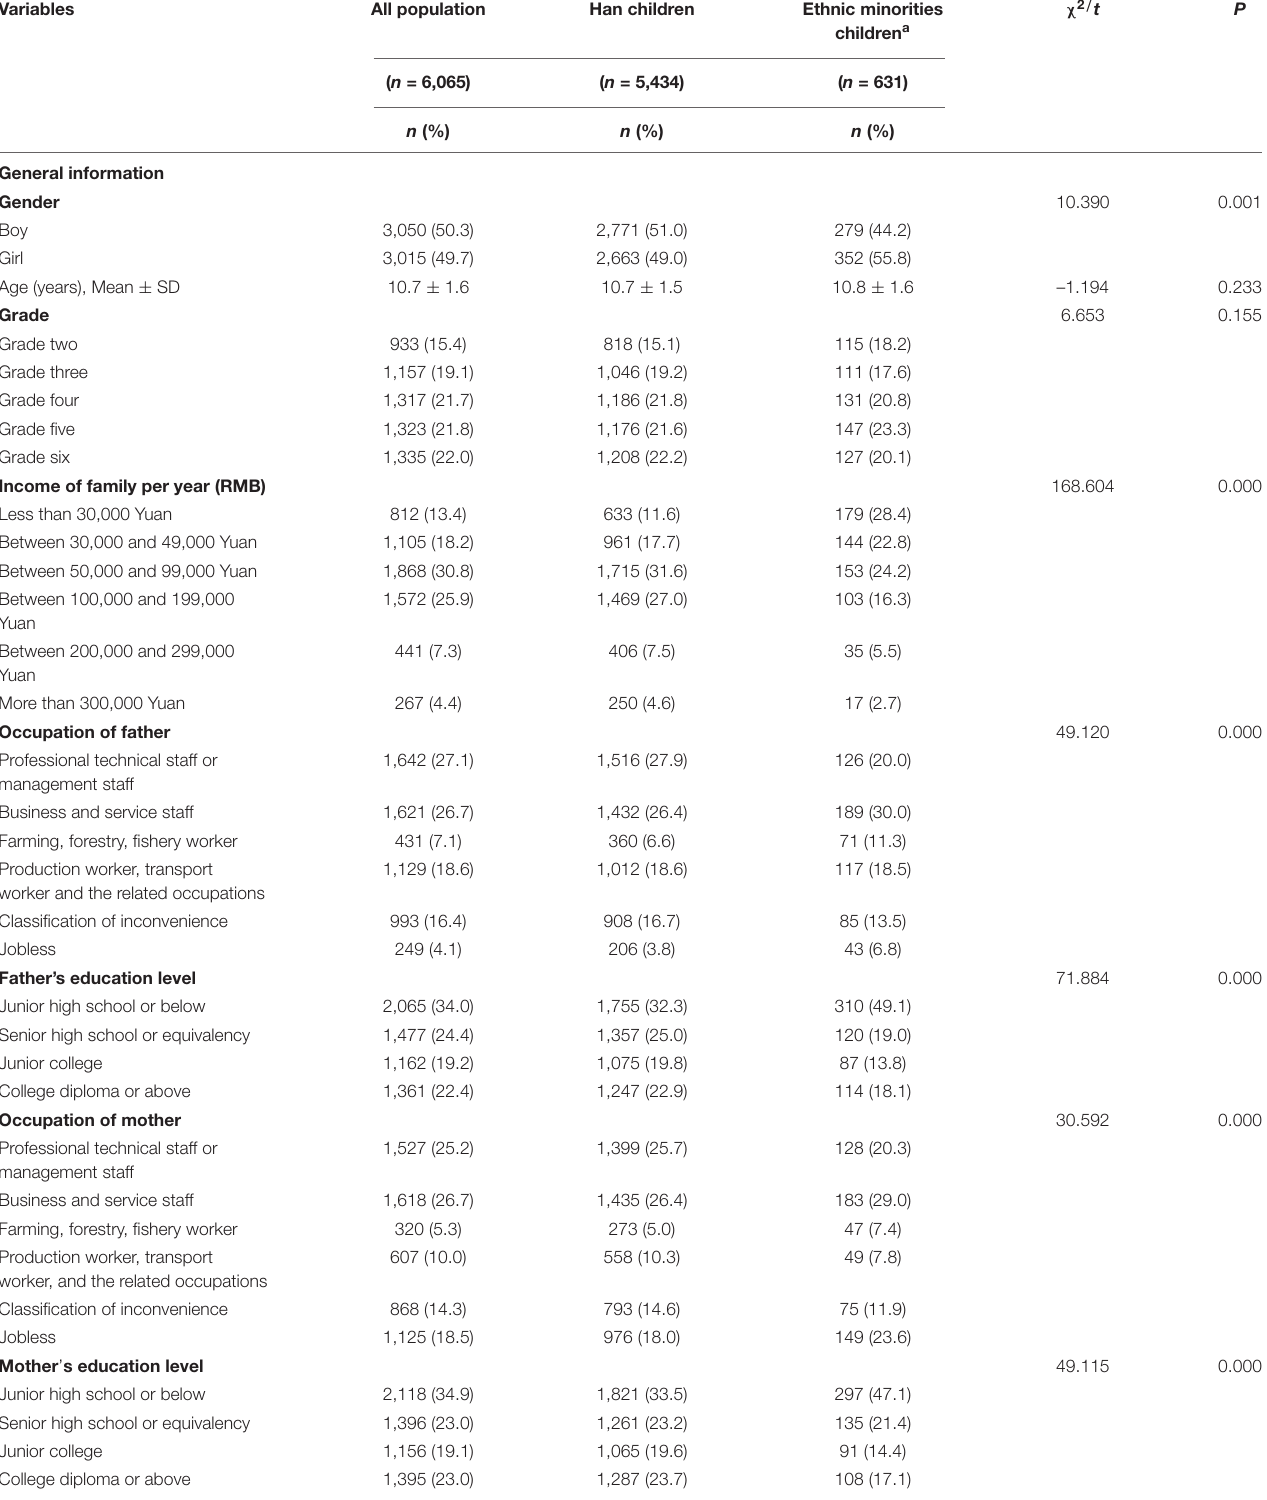
TABLE 1 | Descriptive statistics of the